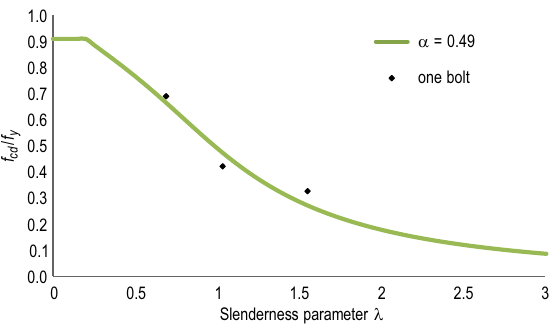
Fig. 16. Comparisons of test result for L 50 × 6 with IS 800-2007 curves ( F